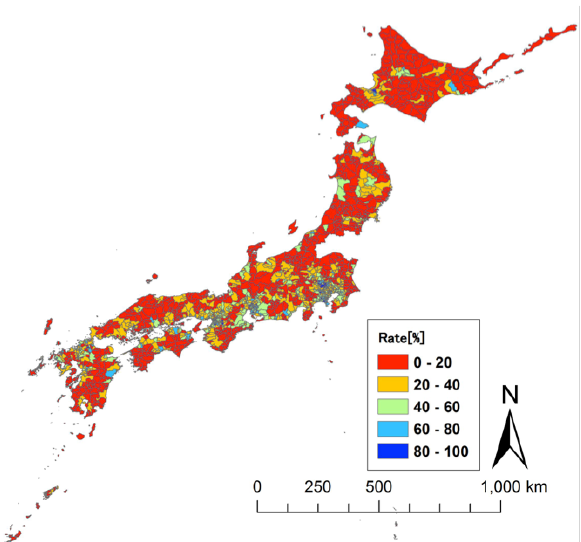
Figure 9. Rates of drugstores that satisfy the survival conditions in